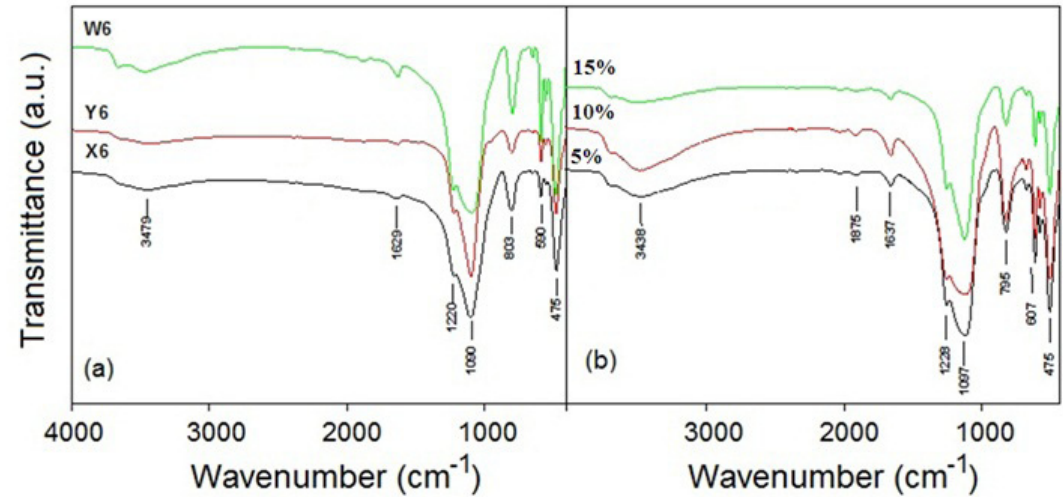
Fig. 5 FTIR spectra for calcined ZSM-12 samples (X6, Y6 W6) (a) and FTIR spectra for calcined TiO 10% of Ti and 15% of Ti